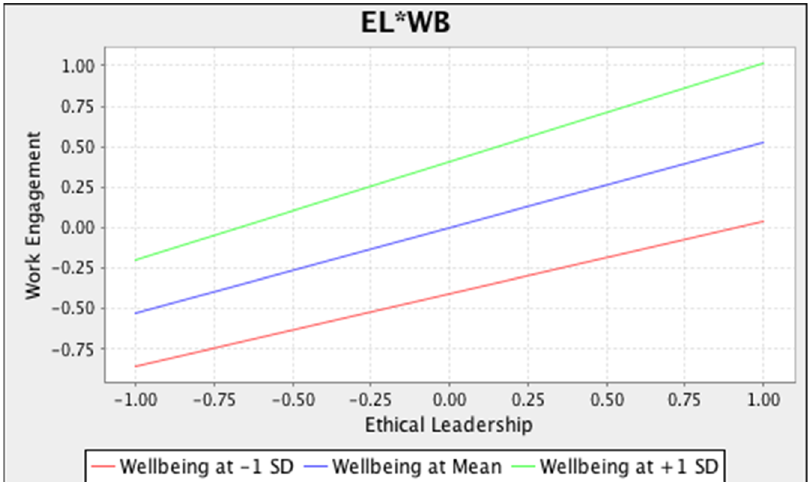
Figure 3. Moderation of EL*WB on Work Engagement.